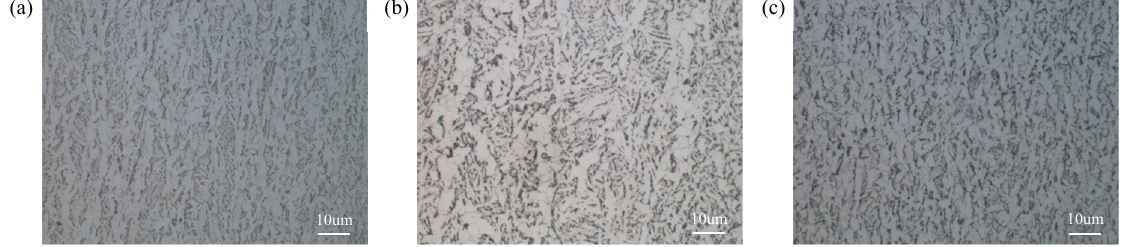
Figure 4. OM images on 1/4 length sections of E36 ( a ), EH36 ( b ) and FH36 ( c ) steel plates.